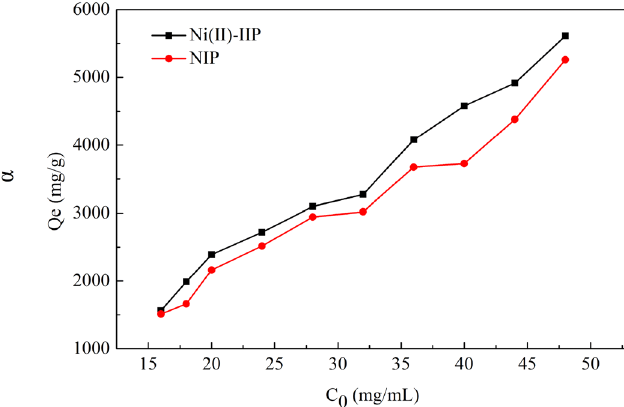
Figure 4: E ff ect of the dosage of cross - linker on adsorption properties. Figure 5: The adsorption isotherm of Ni ( II )- IIP 5 and NIP 5